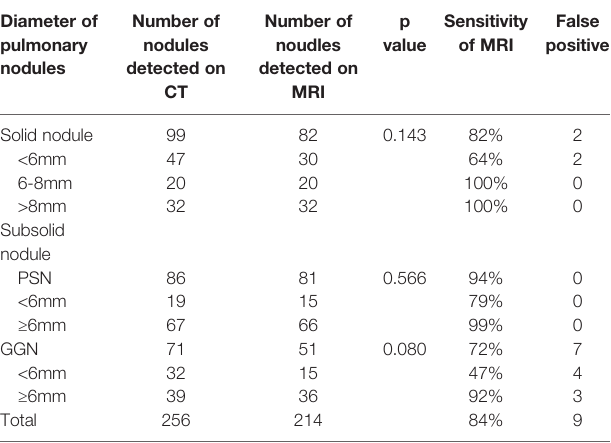
TABLE 2 | The sensitivity of the detection of different subgroups of pulmonary nodules (according to the Fleischner Society nodule size category) and different lobe. Diameter of pulmonary nodules